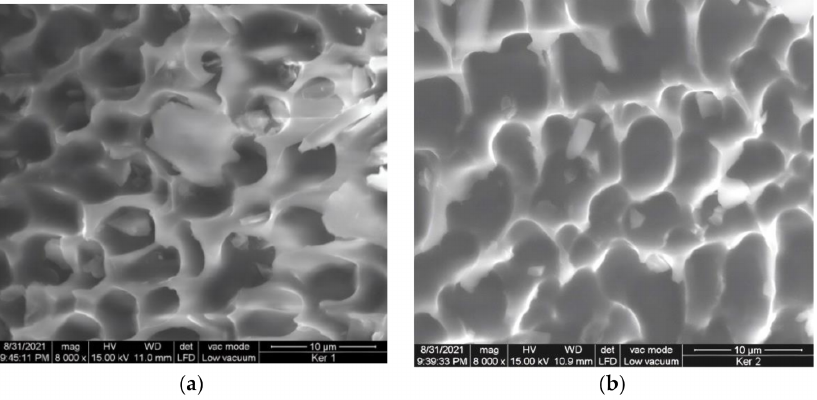
Figure 2. SEM images of lyophilized keratins: ( a ) Ker 1 and ( b ) Ker 2.